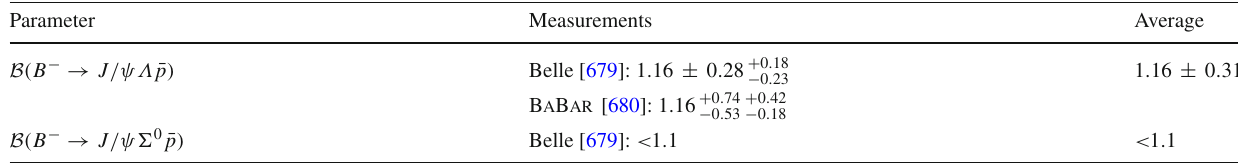
Table 166 Decays with baryons I [ 10 − 5 ]